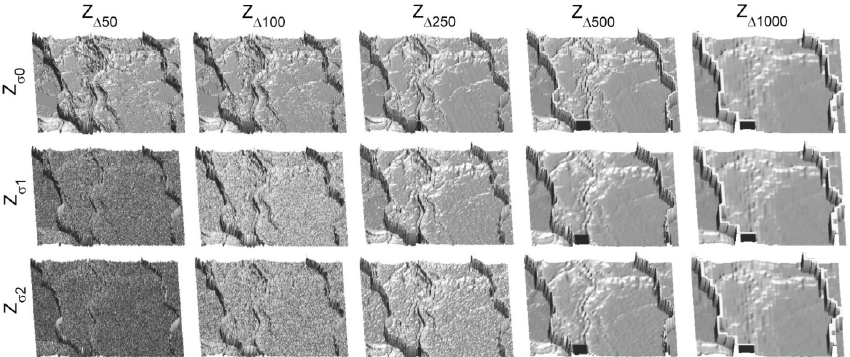
Figure 2. Space-based floodplain digital elevation (Z) maps synthetically generated for floodplain model-sensitivity